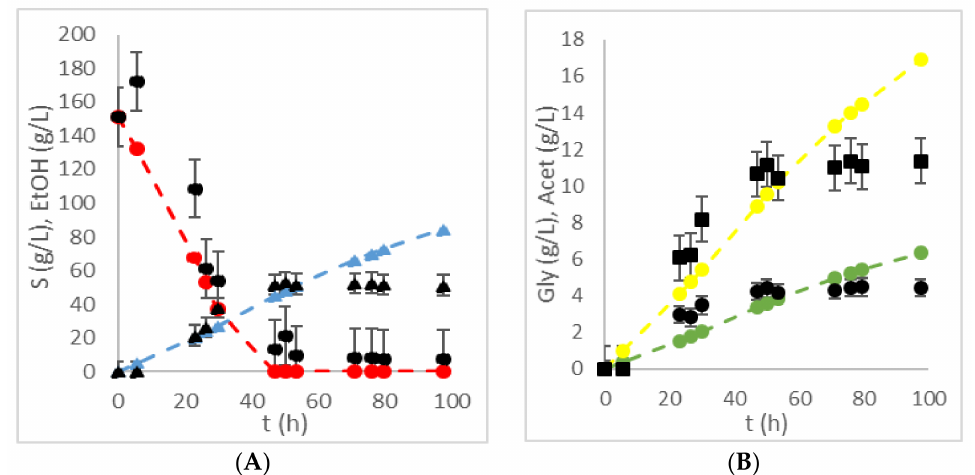
Figure 3. Comparison between experimental (no line) and model values (dashed line) for ( A ) substrate ( • ) and ethanol ( (cid:78) ) concentration and ( B ) glycerol ( (cid:4) ) and acetic acid ( • ) concen- tration obtained for experiment with interval HRTB rotation mode (12 min; 15 rpm) and 17.5 kg of initial mass of sugar beet cossettes. Discrepancies between experimental data are presented as error